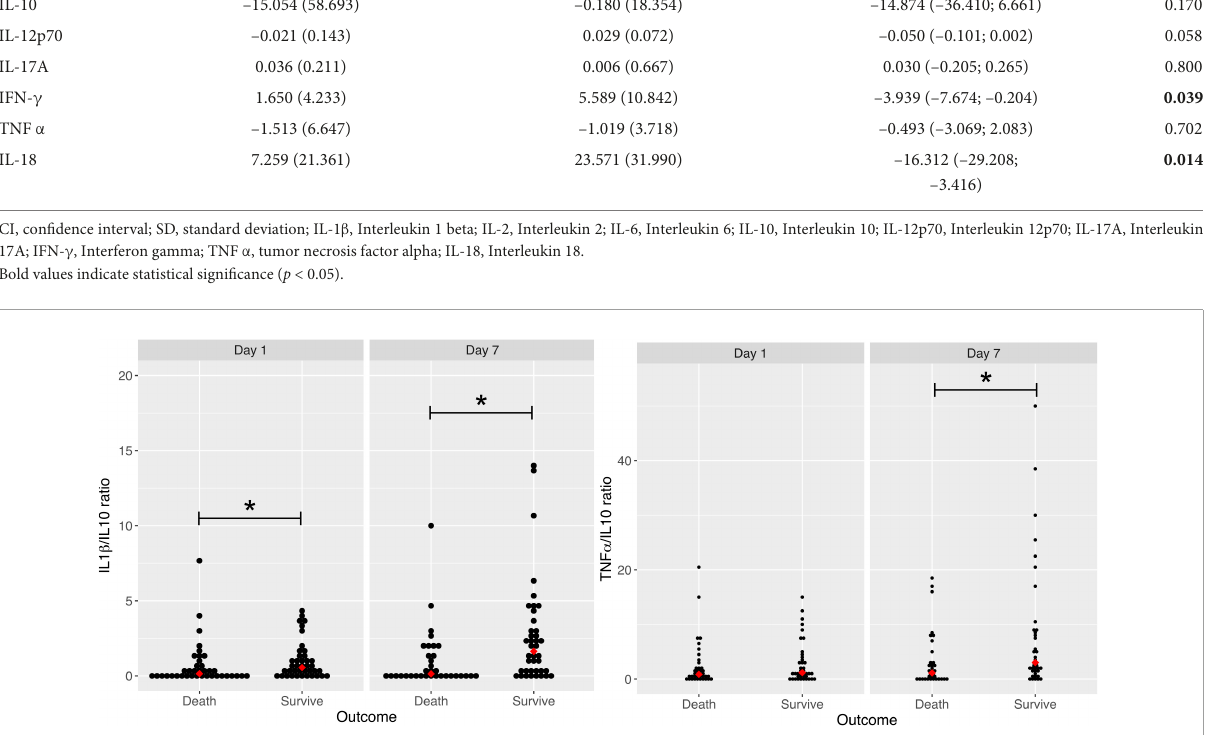
FIGURE3 Comparison of IL-1 β /IL-10 ratio and TNF α /IL-10 ratio concentrations on days 1 and 7 between COVID-19 patients who died and survived. TNF α , tumor necrosis factor alpha; IL-10, Interleukin 10; IL-1 β , Interleukin 1 beta. For IL-1 β /IL-10 ratio: * P value = 0.048 ** P value = 0.002. TNF α /IL-10 ratio: * P value =